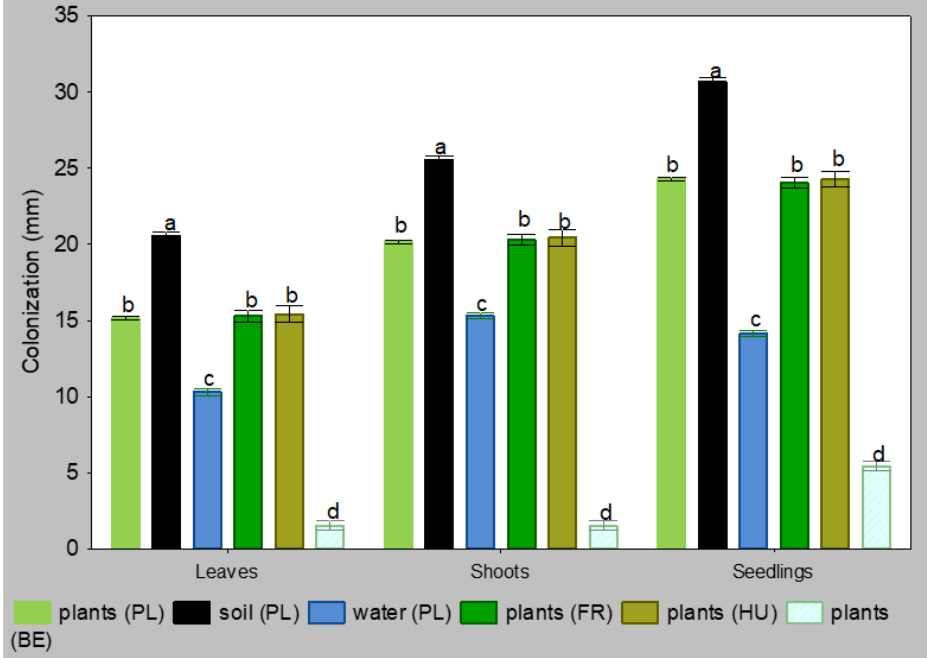
Figure 1. Colonization of leaves, shoots and seedlings of Alnus glutinosa by isolates Phytophthora × alni 5 days after inoculation ( n = 40, means ± SD). Means in the columns, followed by the same letter, were not significantly different using Tukey HSD test at p = 0.05.